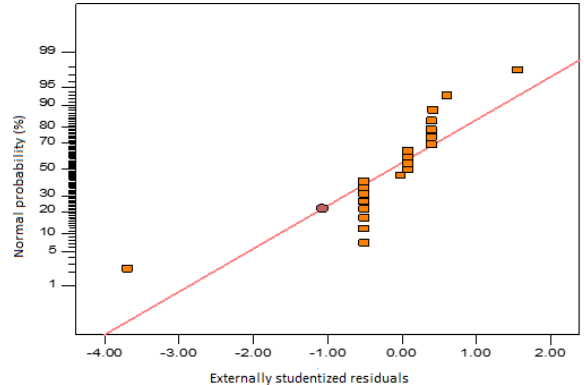
Figure 2: Plot of predicted versus experimental sulphur removal.